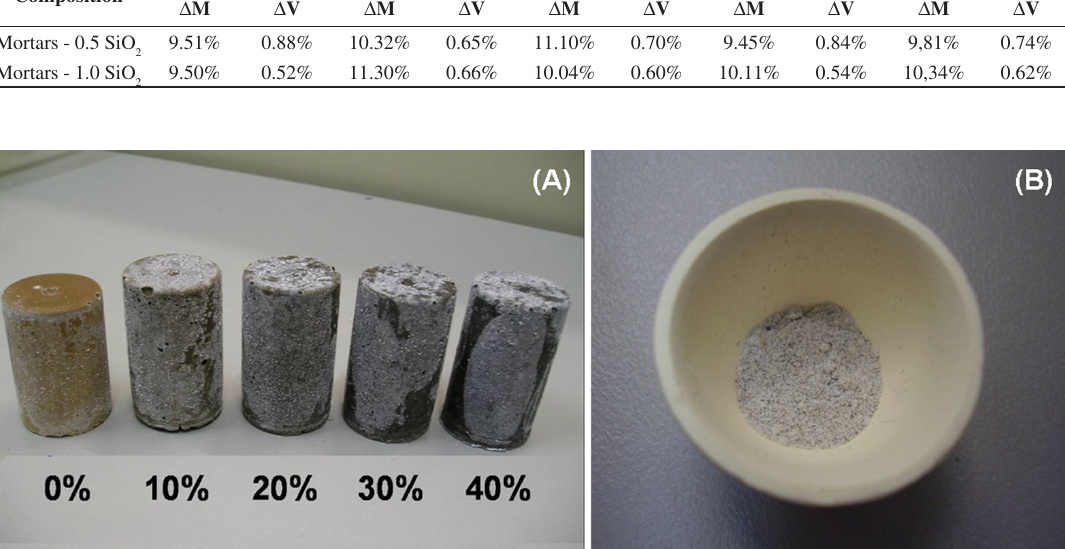
Figure 8. Pictures of samples at 28 days of age that presented efflorescence on their surfaces (A) and efflorescence powder scrapings from the surface of the specimens